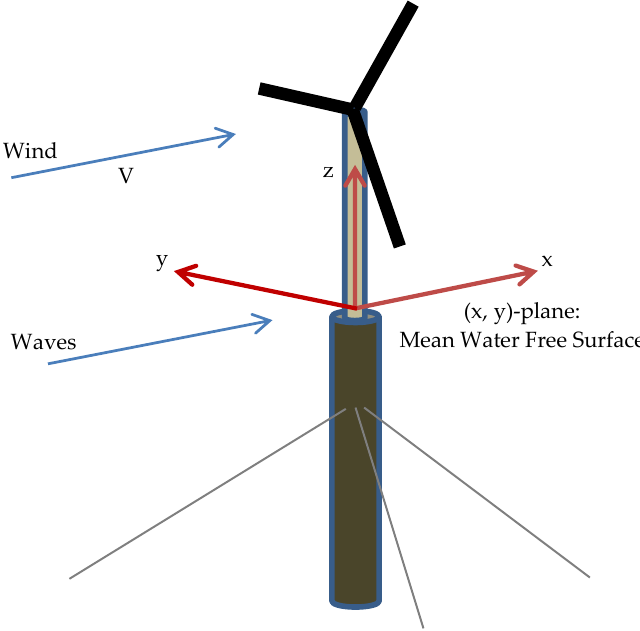
Figure 2. Sketch of the spar-type FOWT and coordinate system.